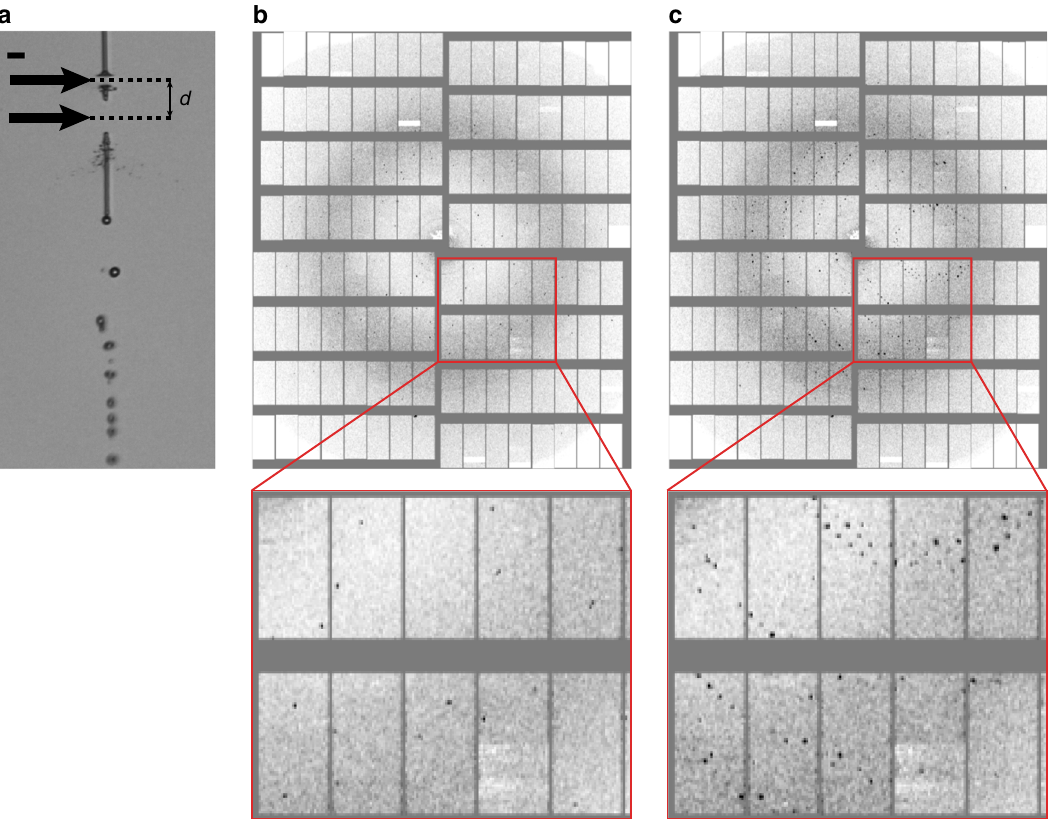
Fig. 1 Consecutive X-ray exposures. a Liquid microjet (lysozyme microcrystals in mother liquor, ~4 µ m jet diameter) after being hit by the fi rst two consecutive X-ray pulses of a pulse train separated by 886 ns, as viewed by the off-axis camera using fs laser illumination shortly after the second X-ray pulse. Flow direction is pointing down in the image. Each X-ray pulse leads to an explosion in the jet, opening up a gap (black arrows). The jet is suf fi ciently fast (~45 m s − 1 ) to close the gap created by the fi rst pulse (lower gap) in time for the second pulse to hit the jet (upper gap). The distance d between both gap centers is ~40 µ m. The scale bar is 20 µ m. b , c Diffraction patterns of lysozyme microcrystals recorded with the fi rst ( b ) and second ( c ) X-ray pulse of the same pulse train (886ns time delay between pulses) showing that the two pulses probed different crystals. a – c All data were recorded from the same sample suspension, using the same nozzle and fl ow